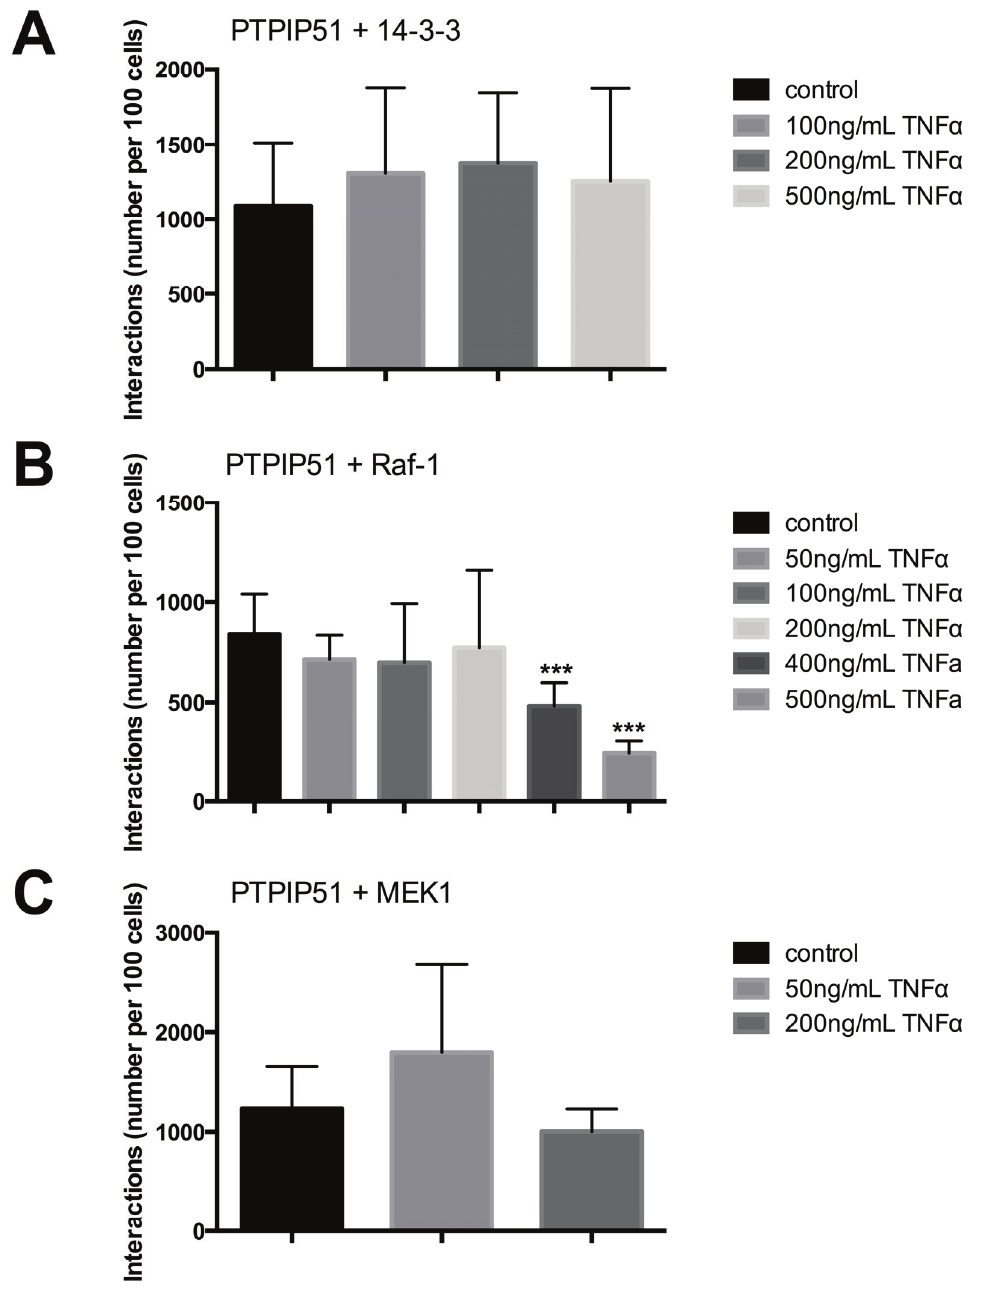
Figure 8. Quantitative analysis of PTPIP51 and 14-3-3, PTPIP51 and Raf-1, PTPIP51 and MEK1 interactions evaluated by Duolink Image Tool software. ( A ) PTPIP51 and 14-3-3 interactions in human keratinocytes. Untreated controls, 50 ng/mL TNF(cid:3) treated cells, 100 ng/mL TNF(cid:3) treated cells, 200 ng/mL TNF(cid:3) treated cells, 400 ng/mL TNF(cid:3) treated cells, 500 ng/mL TNF(cid:3) treated cells; ( B ) PTPIP51 and Raf-1 interactions. Untreated controls, 50 ng/mL TNF(cid:3) treated cells, 100 ng/mL TNF(cid:3) treated cells, 200 ng/mL TNF(cid:3) treated cells, 400 ng/mL TNF(cid:3) treated cells, 500 ng/mL TNF(cid:3) treated cells. *** ( p < 0.001); ( C ) PTPIP51 and MEK1 interactions. Untreated controls, 50 ng/mL TNF(cid:3) treated cells, 100 ng/mL TNF(cid:3) treated cells, 200 ng/mL TNF(cid:3) treated cells, 400 ng/mL TNF(cid:3) treated cells, 500 ng/mL TNF(cid:3) treated cells. The resulting data were analyzed by GraphPad Prism 6 software, significance of results tested by Dunnett’s multiple comparisons